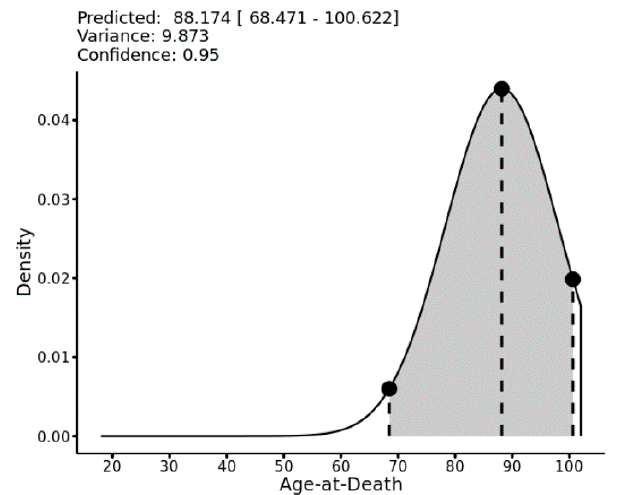
Figure 2. Prediction interval visualization using a (truncated) Gaussian uncertainty model.